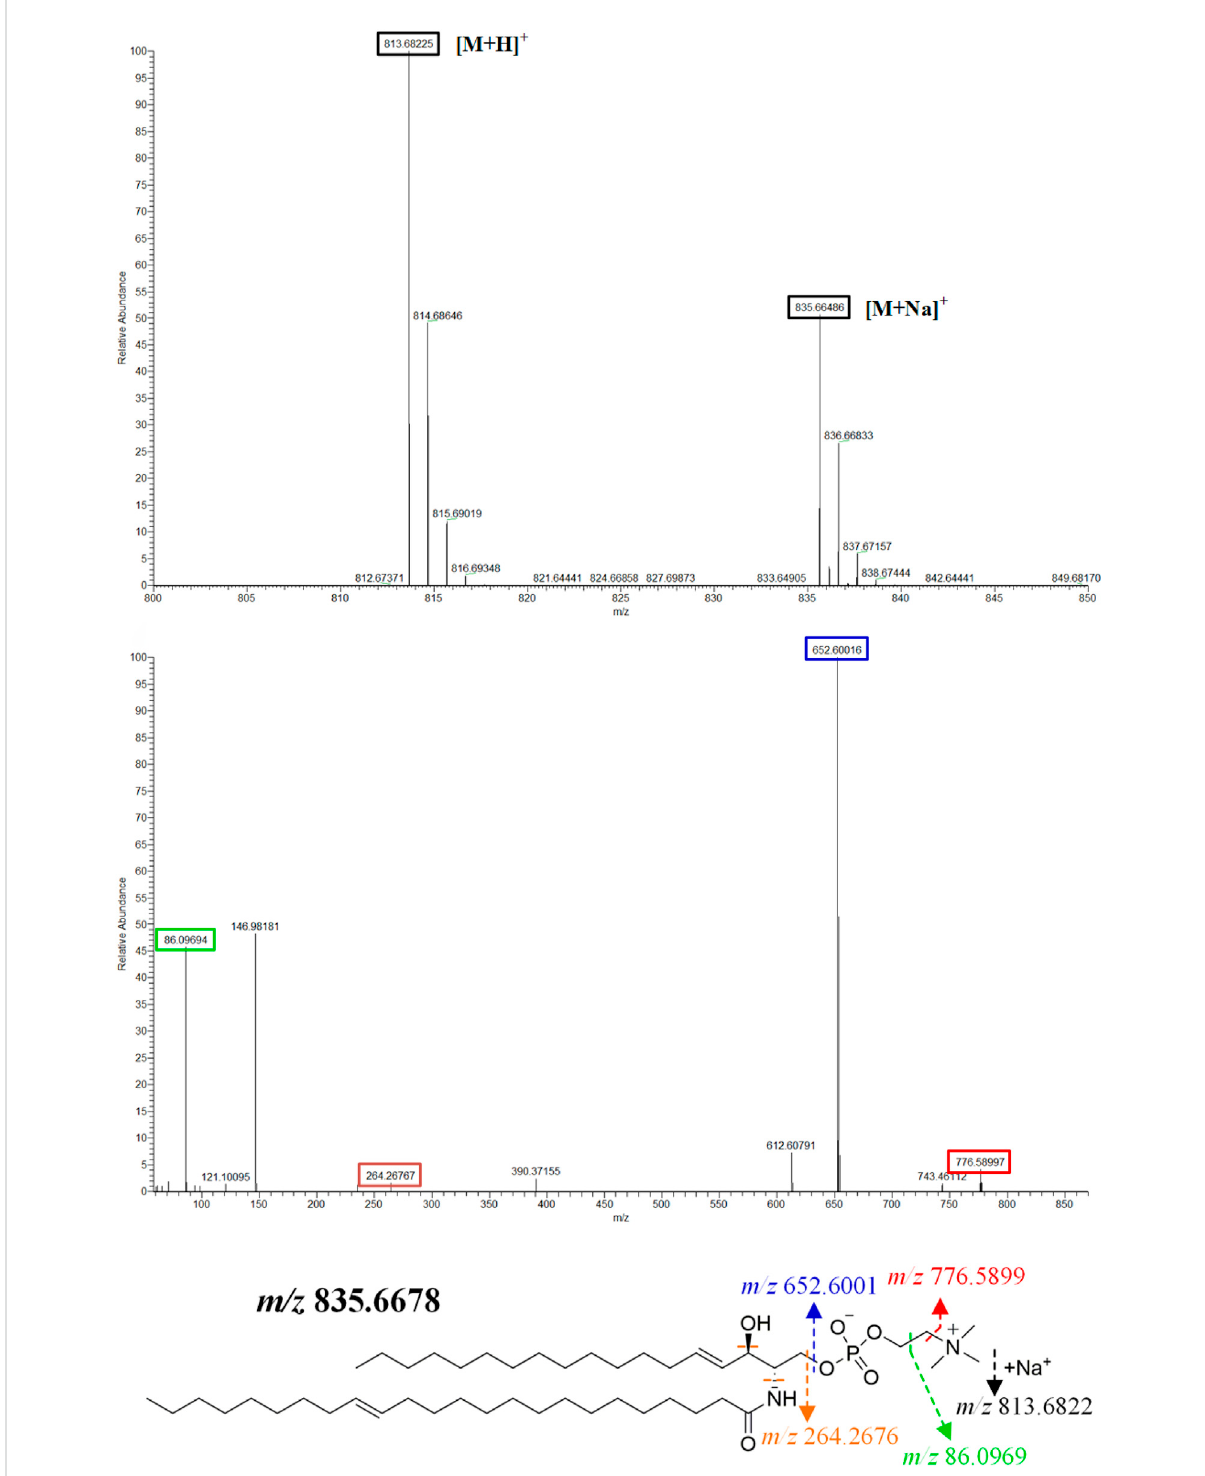
FIGURE 5 | SM (d18:1/24:1 (15Z)) primary and secondary mass spectrometry fragment attribution and cleavage pathways based on